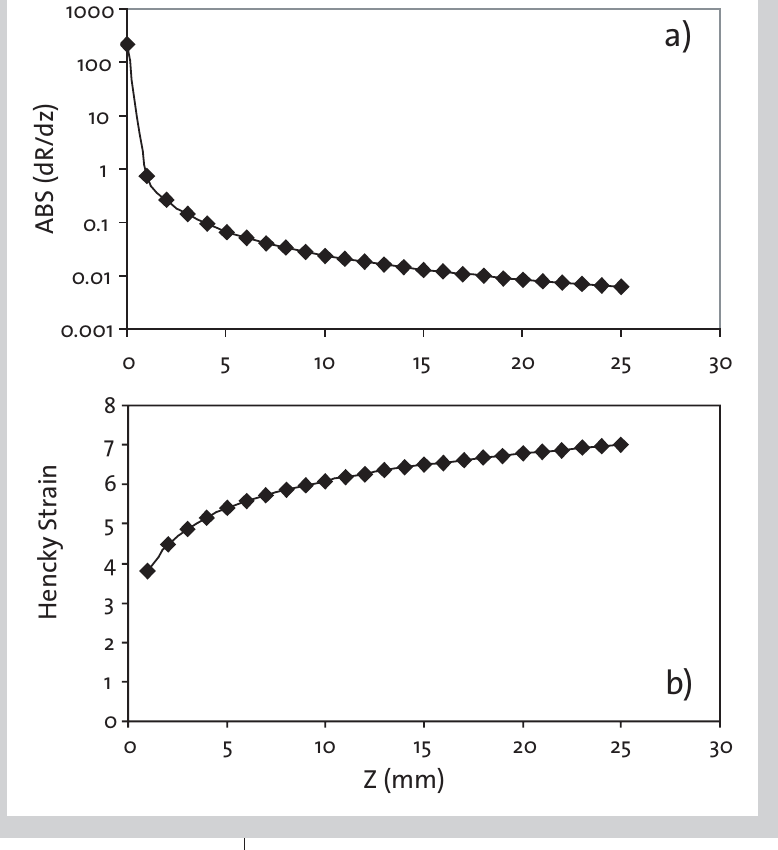
Figure 12: (a) Absolute value of dR/dz (i.e. the variation of the die radius) with distance, z, for a SHPB die. We note that - dR/dz = tan q . (b) The associ- ated Hencky strain (die = 10 mm, dimensions: R o z = 0.022818 mm, and o z = 25 mm) as a function of e the distance